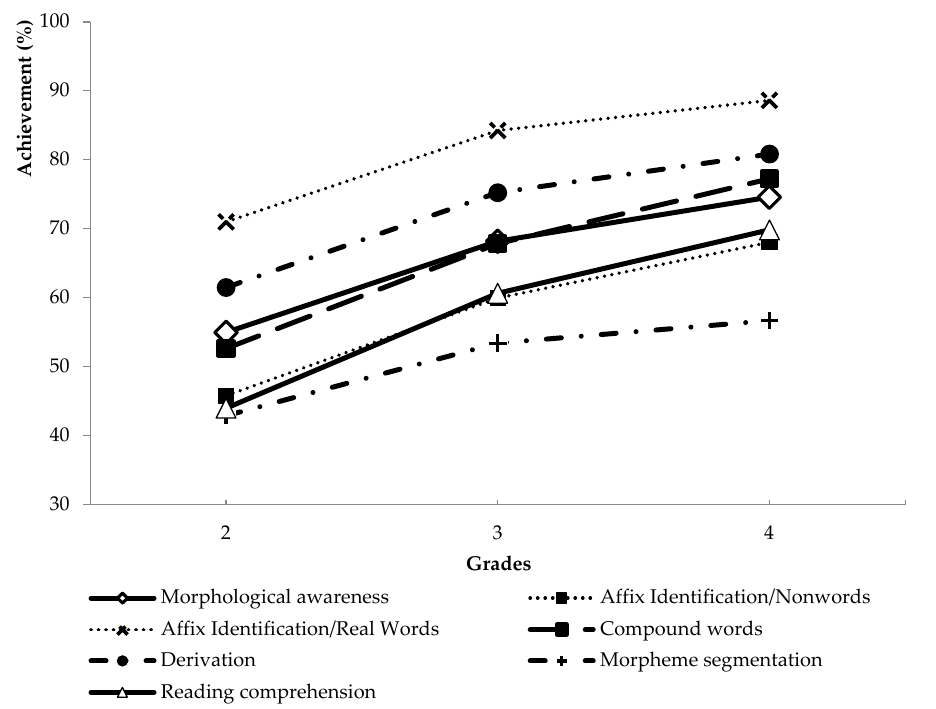
Figure 5. The development of different skills related to morphological awareness and reading comprehension in grades 2–4.